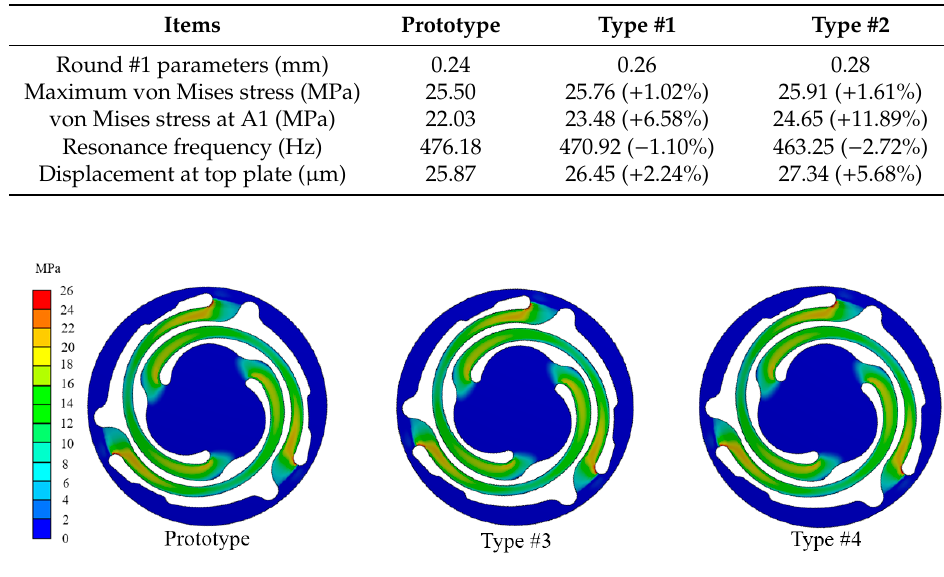
Figure 19. von Mises stress distribution on spring with different round #2 parameters. Table 4. Analysis result comparison between different round #2 parameters.